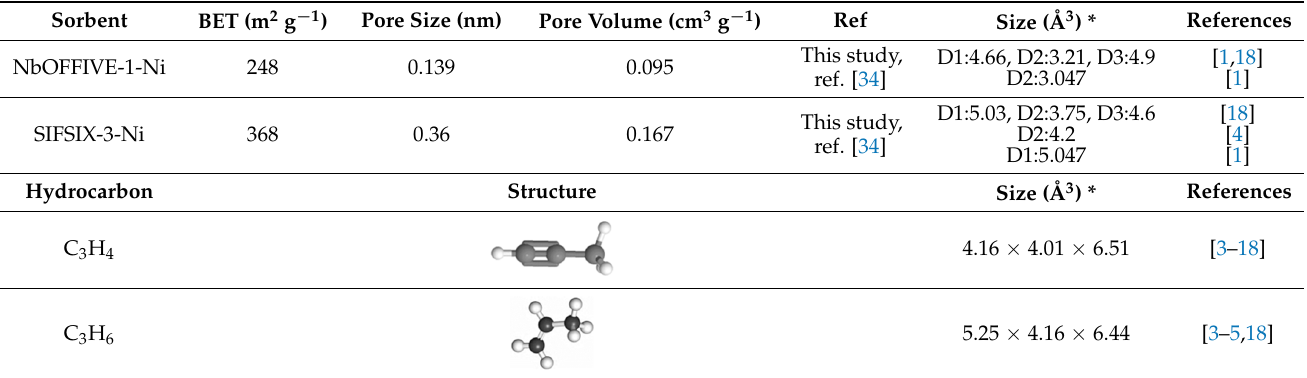
Table 1. Characteristic information for adsorbents and adsorbate gases.